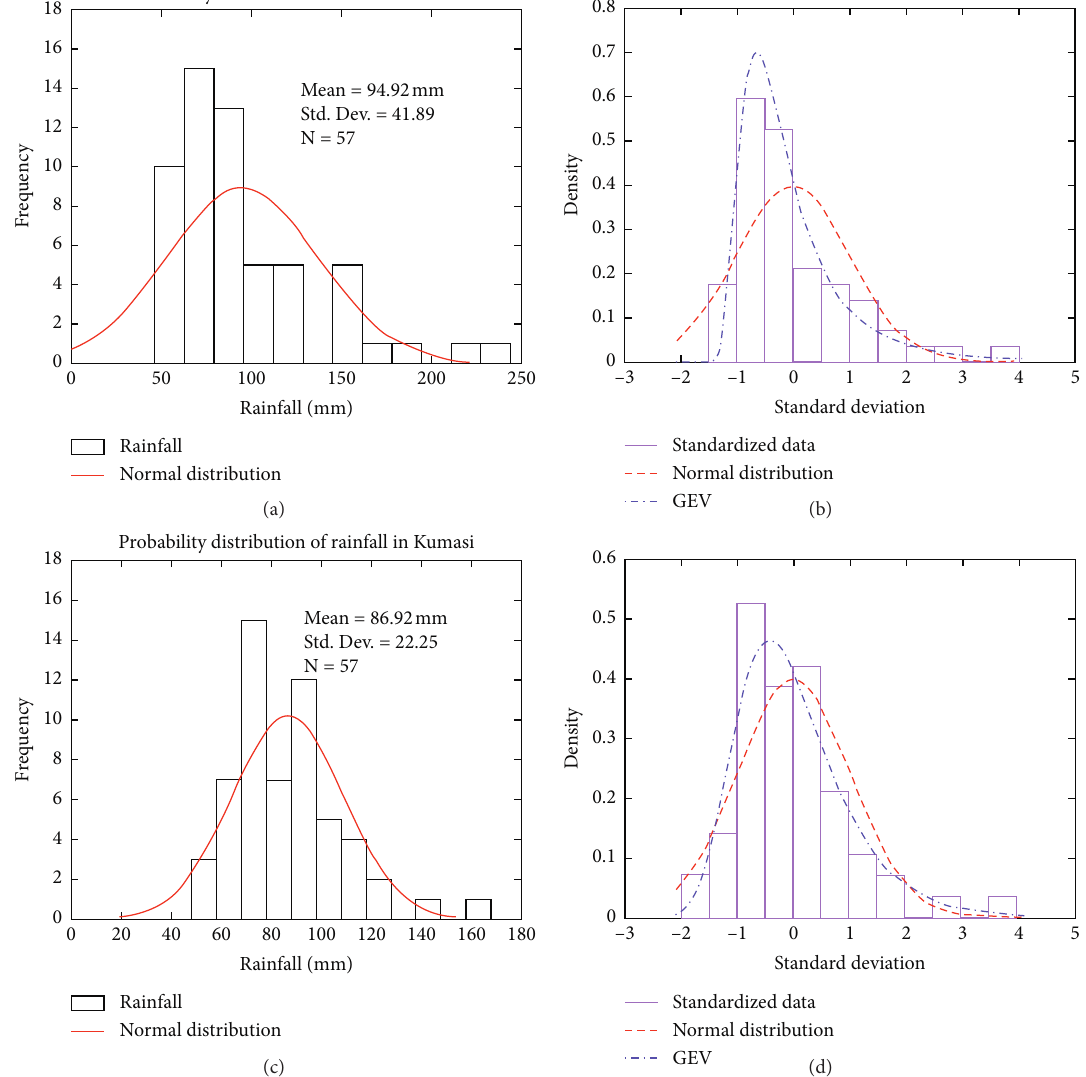
Figure 9: Normal and standardized rainfall distribution. Plots (a) and (b) and (c) and (d) for cases A and B,